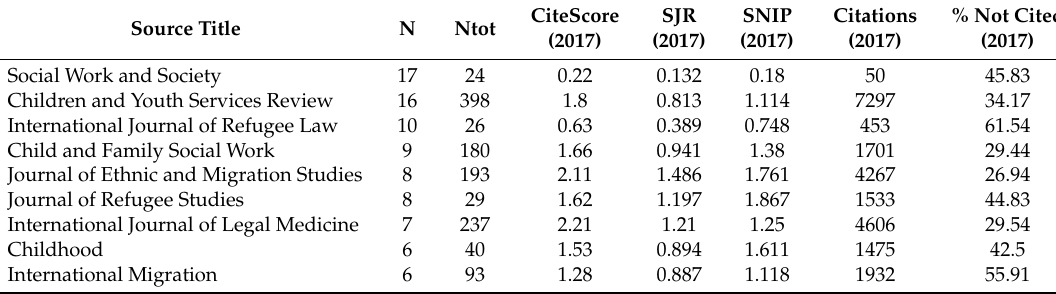
Table 1. Main journals and their indicators.